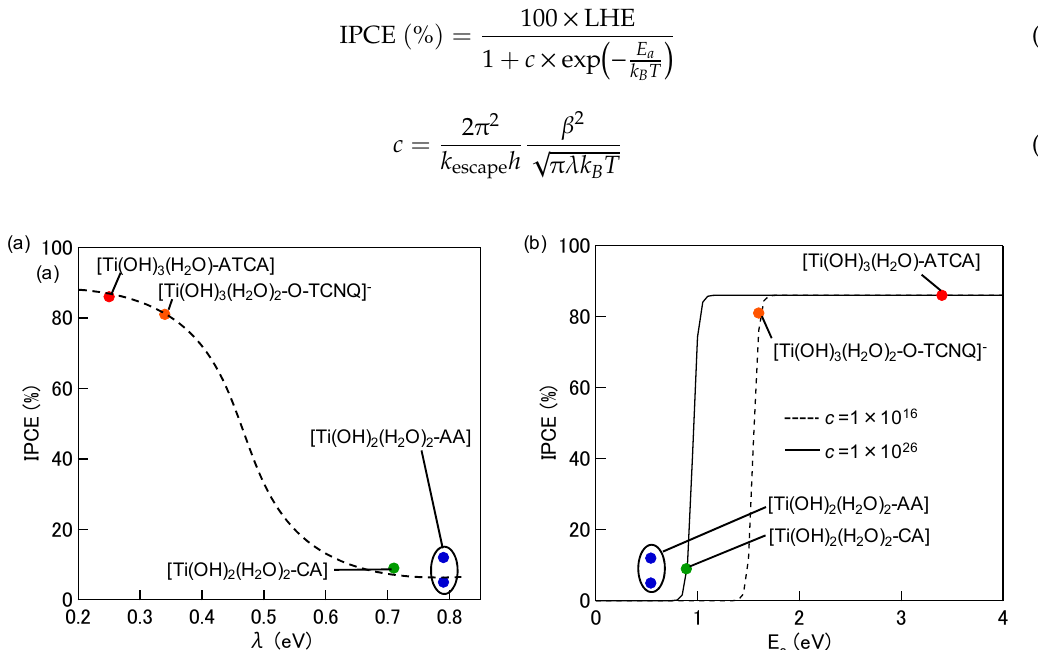
Figure 8. ( a ) Correlation between the reported IPCE and calculated reorganization energy ( λ ) and ( b ) correlation between the reported IPCE and activation energy ( E a ) calculated with the calculated reorganization energy and experimentally-estimated Δ E value. See text for detail. Adapted with permission from Reference 2. Copyright 2015 the PCCP Owner Societies.